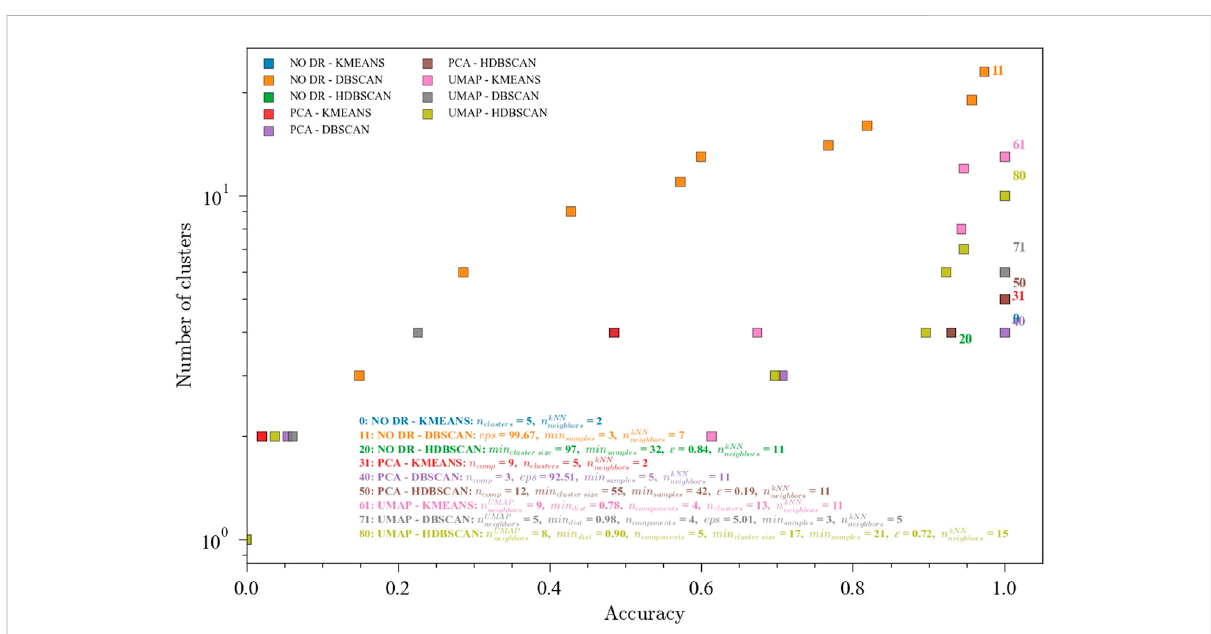
FIGURE 7 Pareto fronts for themulti-objective(accuracy andnumber ofclusters)optimization of theensembles.The hyperparametersfor 1.0accuracies are shown and one for each ensemble. Data from the pyrolysis reactor with 3 labeled faults. Ensembles: (0) NO DR-KMEANS, n clusters (cid:1) 5, n kNN neighbors (cid:1) 2; (11) NO DR-DBSCAN, eps (cid:1) 99 . 67, min samples (cid:1) 3, n kNN neighbors (cid:1) 7; (20) NO DR-HDBSCAN, min cluster size (cid:1) 97, min samples (cid:1) 32, ε (cid:1) 0 . 84, n kNN neighbors (cid:1) 11; (31) PCA-KMEANS, n components (cid:1) 9, n clusters (cid:1) 5, n kNN neighbors (cid:1) 2; (40) PCA-DBSCAN, n components (cid:1) 3, eps (cid:1) 92 . 51, min samples (cid:1) 5, n kNN neighbors (cid:1) 11; (50) PCA-HDBSCAN, n components (cid:1) 12, min cluster size (cid:1) 55, min samples (cid:1) 42, ε (cid:1) 0 . 19, n kNN neighbors (cid:1) 11; (61) UMAP-KMEANS, n UMAP neighbors (cid:1) 9, min dist (cid:1) 0 . 78, n components (cid:1) 4, n clusters (cid:1) 13, n kNN neighbors (cid:1) 11; (71)UMAP-DBSCAN, n UMAP neighbors (cid:1) 5, min dist (cid:1) 0 . 98, n components (cid:1) 4, eps (cid:1) 5 . 01, min samples (cid:1) 3, n kNN neighbors (cid:1) 5; (71) UMAP-HDBSCAN, n UMAP neighbors (cid:1) 8, min dist (cid:1) 0 . 90, n components (cid:1) 5, min cluster size (cid:1) 17, min samples (cid:1) 21, ε (cid:1) 0 . 72, n kNN neighbors (cid:1)